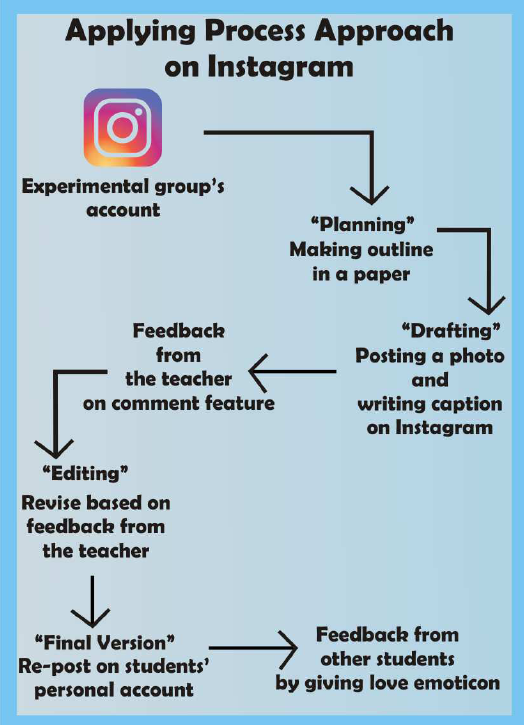
Figure 1. Process approach applied in experimental group